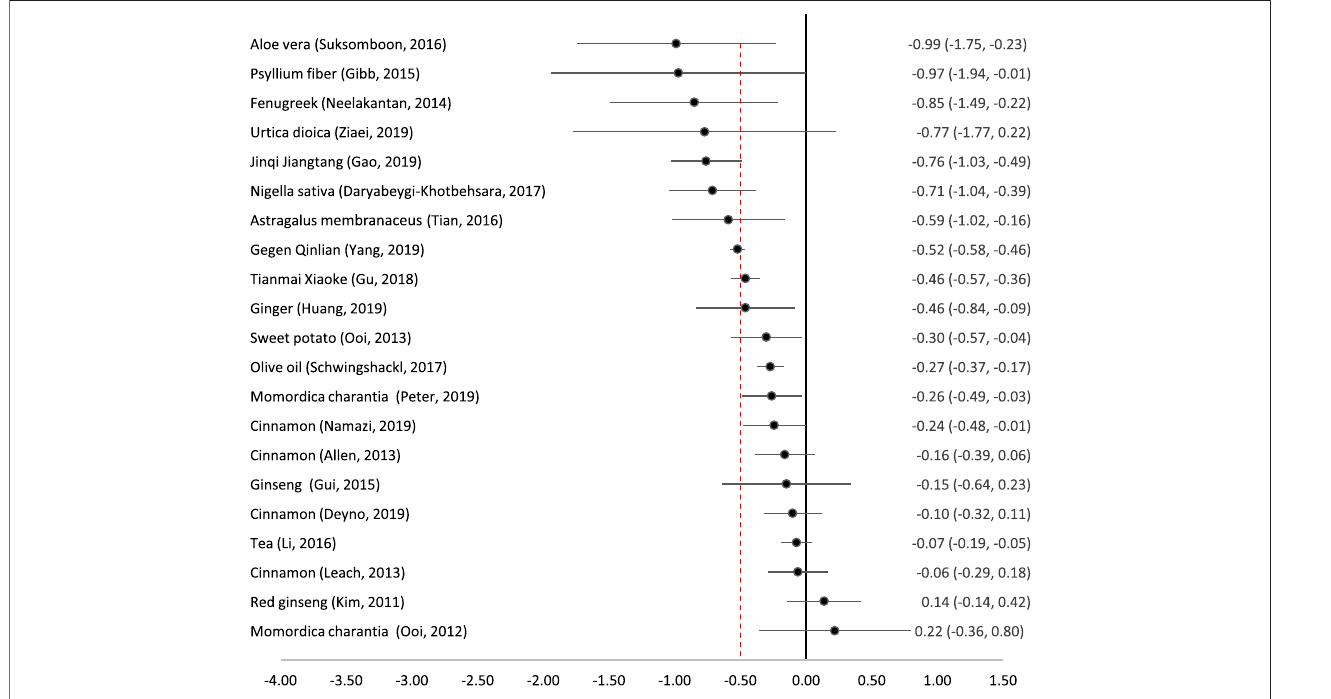
FIGURE 2 | Effect of medicinal plants on HbA1c (%). The red dotted line indicates the threshold for a clinically signi fi cant effect (reduction by 0.5%). Point indicates the effect size, and the line (and fi gures to the right) indicate the 95% con fi dence interval.